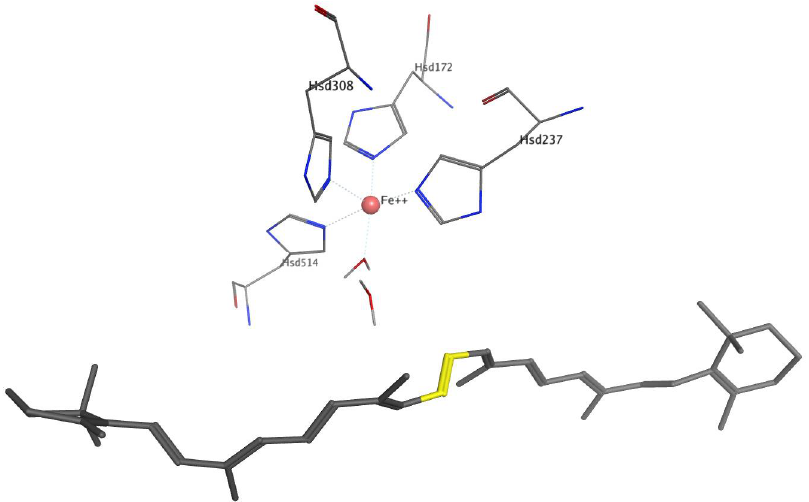
Figure 2. Two-dimensional representation of the β-carotene (gray rods, and in yellow the 15–15’ bond) and the coordination center, for BCO1. The Fe 2+ atom, represented by a pink sphere, coordinates with His172, His237, His308, His514 and two water molecules (TIP2089 and TIP2035), all represented by thin rods and colored according to atom type. The average bond distances (in Å) between Fe 2+ and the histidine nitrogens are 2.030 ± 0.075, 2.08 ± 0.084, 2.11 ± 0.096 and 2.12 ± 0.11, respectively. Between Fe 2+ and the oxygens of water, the distances are 1.97 ± 0.079 and 1.94 ± 0.067, respectively.